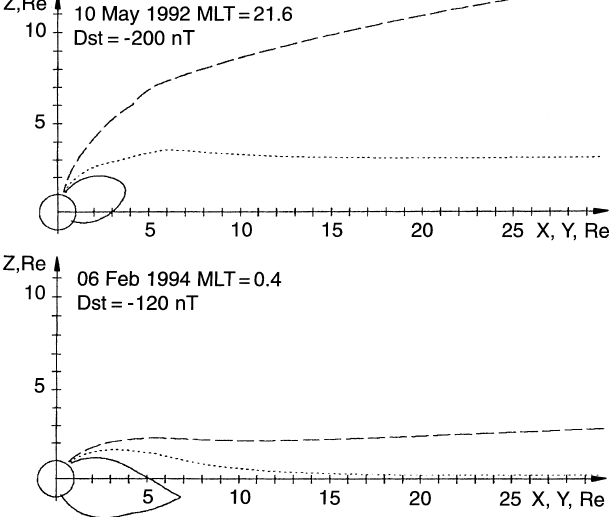
Fig. 9. Similar to Fig. 8 for